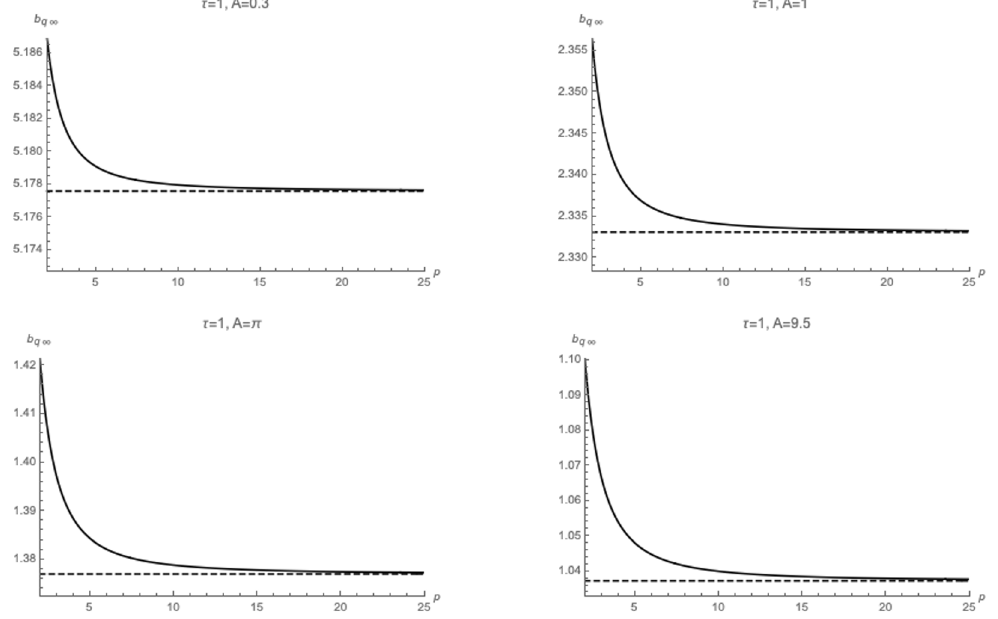
Figure 9 . Plot of b q, ∞ as a function of p at τ = 1 . The four plots correspond to A = 0 . 3 , 1 , π, 9 . 5 . The dashed horizontal line is the corresponding value of b ∞ in TT -deformed Yang-Mills theory without q -deformation. Figure 10 . Plot of b q, ∞ as a function of p at τ = 12 . The four plots correspond to A = 0 . 3 , 1 , π, 6 . The dashed horizontal line is the corresponding value of b ∞ in TT -deformed Yang-Mills theory without q